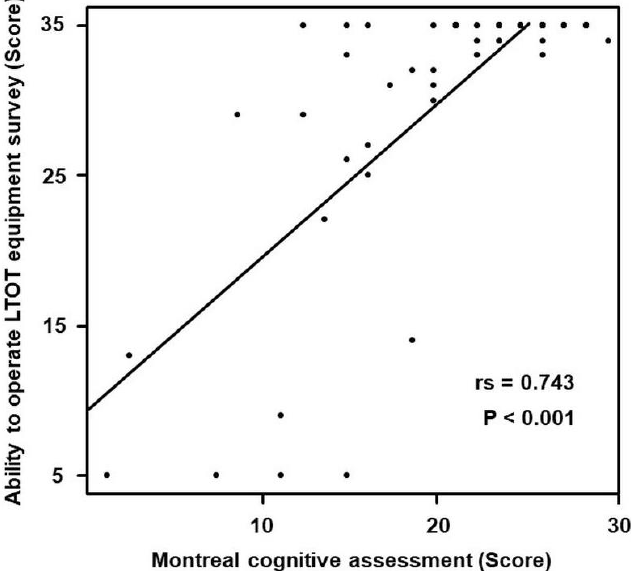
Figure 2. Correlation between the ability to operate long-term oxygen therapy (LTOT) equipment survey and Montreal Cognitive Assessment. The ability to operate LTOT equipment and cognitive function (rs = 0.743, p < 0.001) were positively correlated.